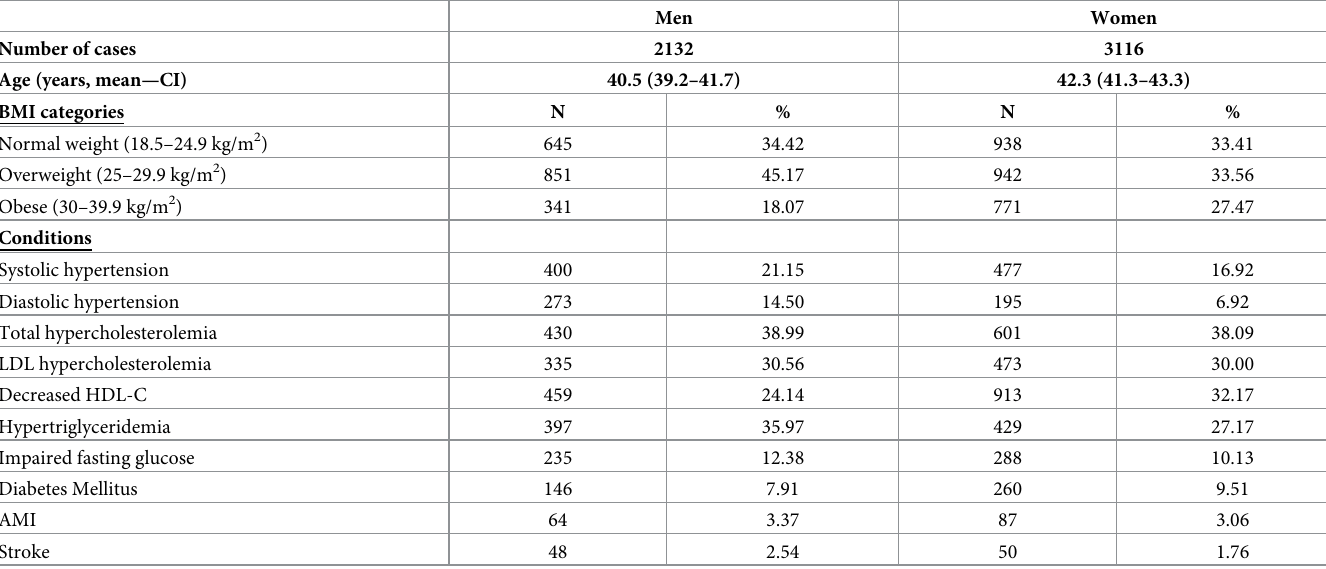
Table 1. General characteristics of the sample.